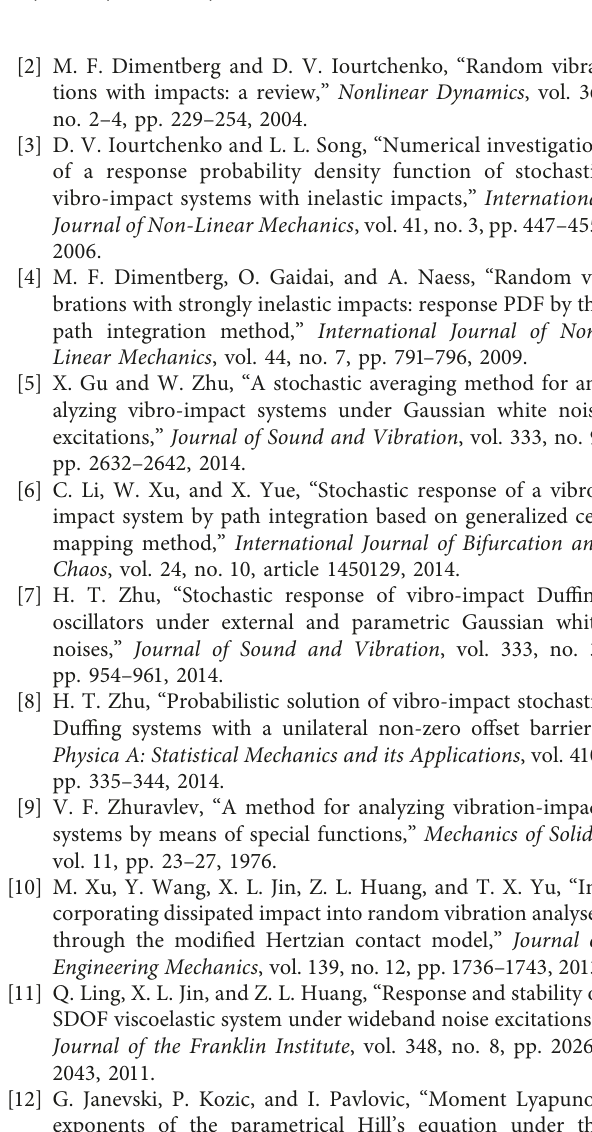
Figure 8: The marginal probability densities of system responses (solid lines: the proposed results; discrete symbols: Monte Carlo simulation results). (a) The probability density of displacement X ; (b) the probability density of velocity _ X